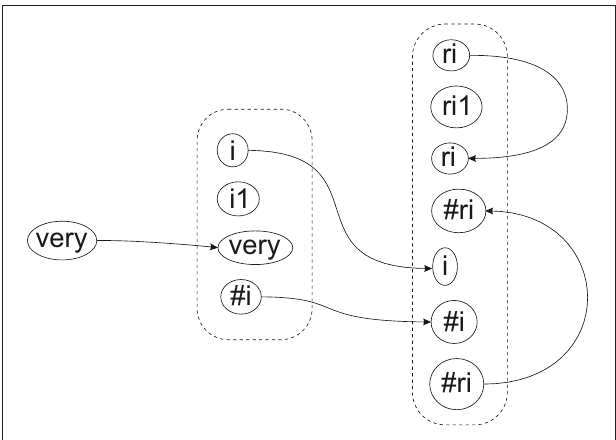
FIGURE 9 | A schematic example showing how recursive structures may be modeled in